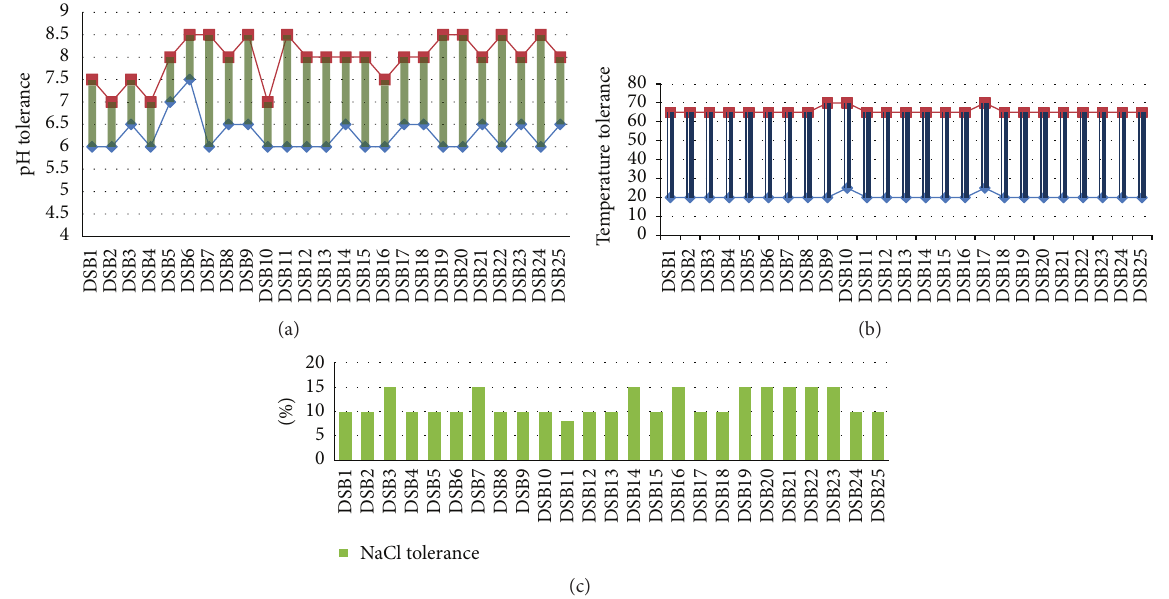
Figure 5: Line and bar diagrams showing (a) pH tolerance, (b) temperature tolerance, and (c) NaCl tolerance level of the isolated Bacillus spp.